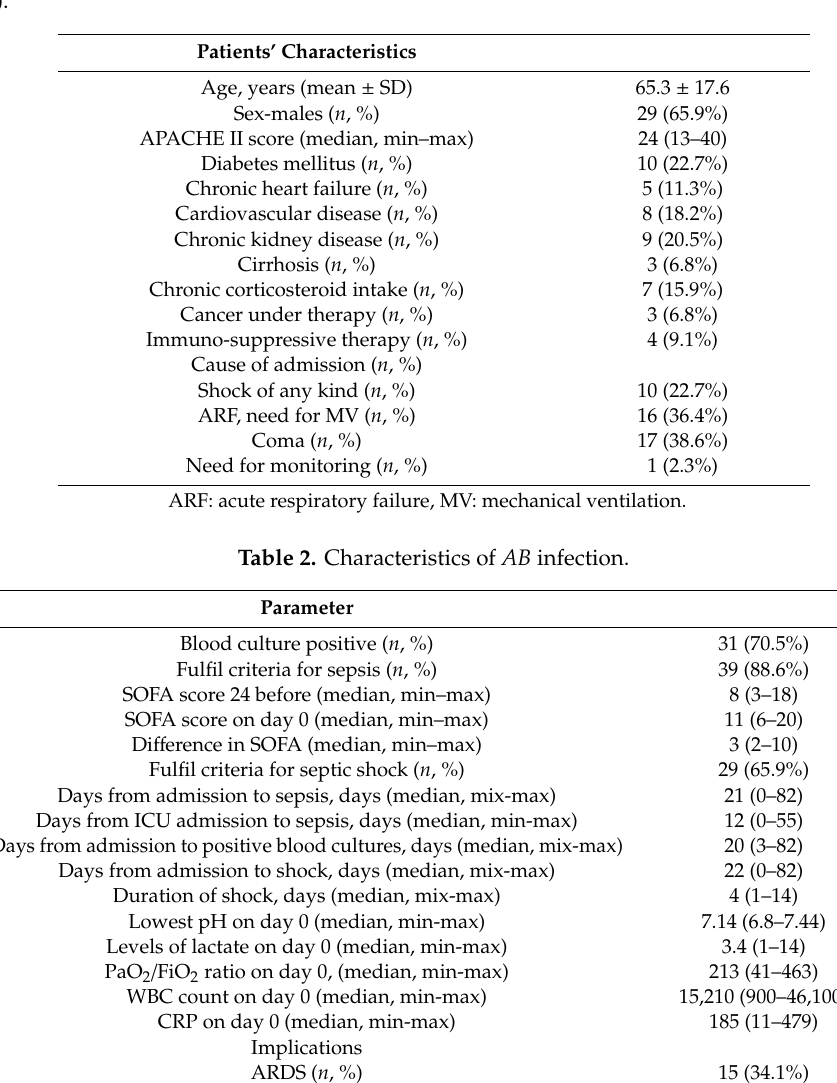
Table 1. Characteristics of the total cohort of ICU patients with XDR-AB infection (total study population n = 44).